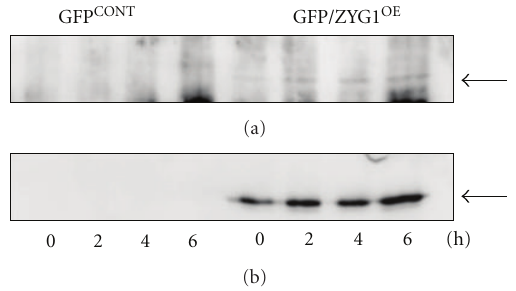
Figure 3: Phosphorylation of GFP/ZYG1 fusion protein by cPKC. GFP CONT and GFP/ZYG1 OE cells were collected at 2-hour intervals after starvation. Each sample was separated by 10% SDS-PAGE, fol- lowed by Western blottings using the rabbit Phospho-(Ser) PKC Substrate antibody and the rabbit anti-GFP antibody. Hours after starvation are designated at the bottom. The GFP/ZYG1 fusion pro- tein (67.4kDa) is phosphorylated by cPKC (a; arrow), while no bands around 67.4 KD are detected in the samples obtained from GFP CONT cells. GFP/ZYG1 OE cells also express GFP protein, as detected by the anti-GFP antibody (b;